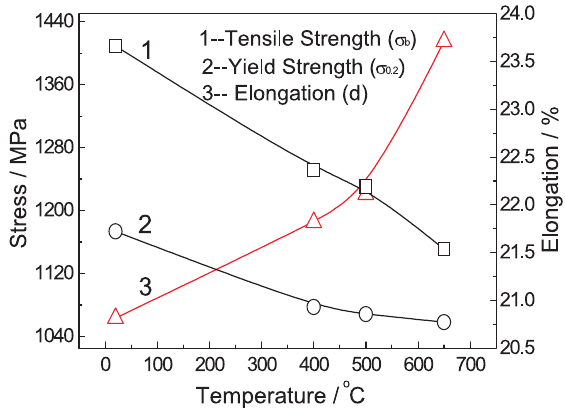
Fig. 3: Dependence of mechanical properties of GH4169 alloy on temperatures